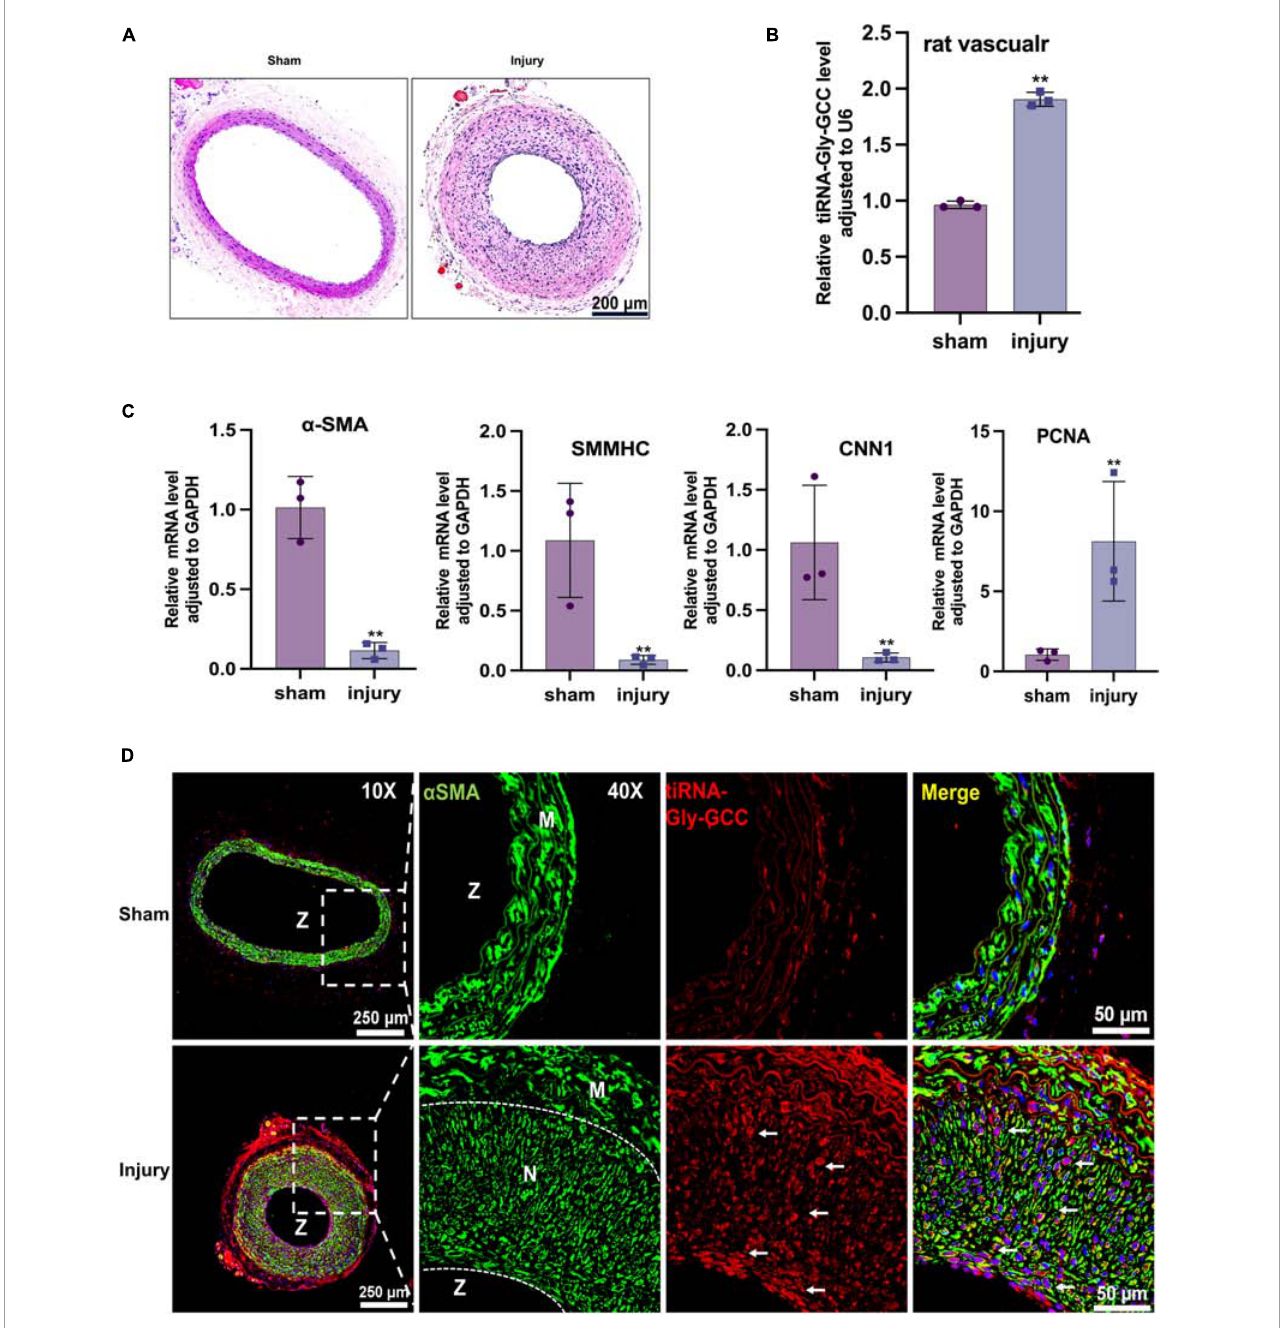
FIGURE3 The tiRNA-Gly-GCC expression pattern in the rat vascular injury model. (A) Representative HE staining of sham and injured rat carotid arteries. n = 3; scale bar, 200 µ m. (B) qRT-PCR showing the expression of tiRNA-Gly-GCC in sham and injured arteries. Data were normalized to U6. Data are presented as the mean ± SD. n = 3, **p < 0.01. (C) qRT-PCR showing the mRNA levels of VSMC-specific genes ( α -SMA, SMMHC and CNN1) and PCNA in sham and injured arteries. Data were normalized to GAPDH. Data are presented as the mean ± SD. n = 3, **p < 0.01. (D) Representative RNA-FISH and immunofluorescence staining of sham and injured arteries. tiRNA-Gly-GCC (red, cy3 labeled); α -SMA (green, 488-labeled); and DAPI (blue, labeled nucleus). The upper panel refers to sham and the lower panel to injured arteries. n = 3, scale bar, 250, 50 µ m. N, neointimal; M, vascular media; Z, zoom of